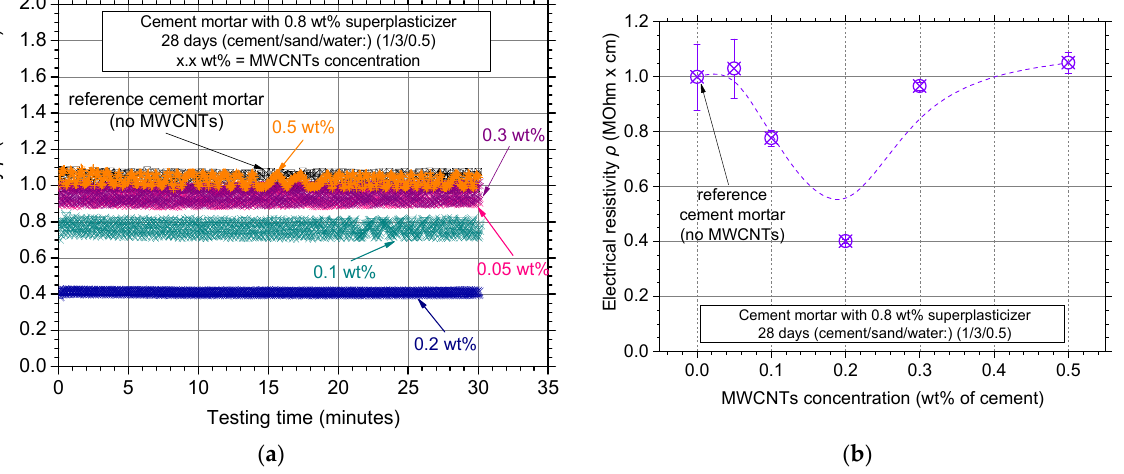
Figure 10. ( a ) Electrical resistivity curves over testing time and ( b ) average electrical resistivity values of nanocomposites with different MWCNT concentrations. Typical experimental curves of flexural stress–CMOD can be seen in Figure 11a for the investigated MWCNT concentrations. It is evident that all MWCNT additions had a profound effect on the flexural strength of the specimens, with the optimal concentration being around 0.2 wt%. Lower concentrations could not sufficiently reinforce the matrix, while non-uniform dispersion of the reinforcement might be the reason for the flexural strength decrease for higher concentrations.